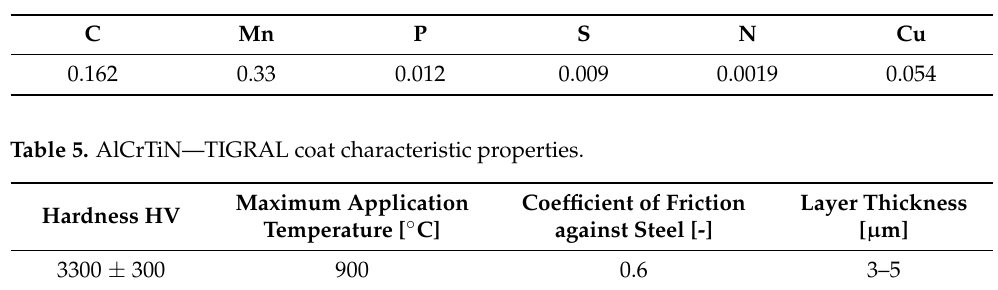
Table 4. Chemical composition of S235JR + AR steel (%).